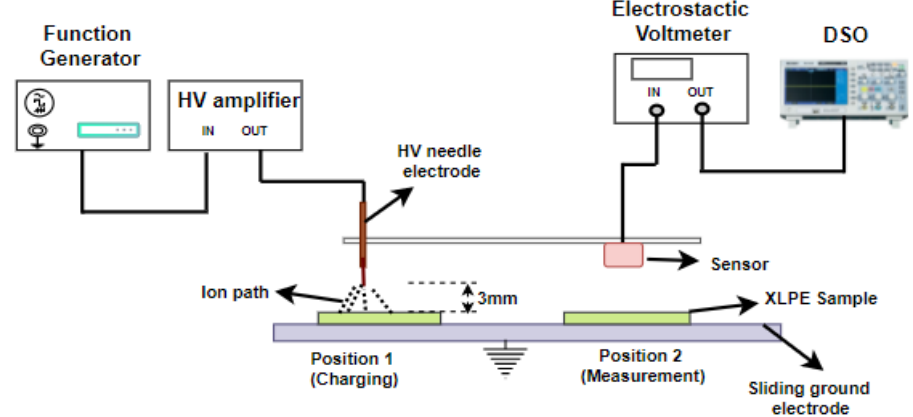
Figure 1. Schematic representation of surface potential decay system.